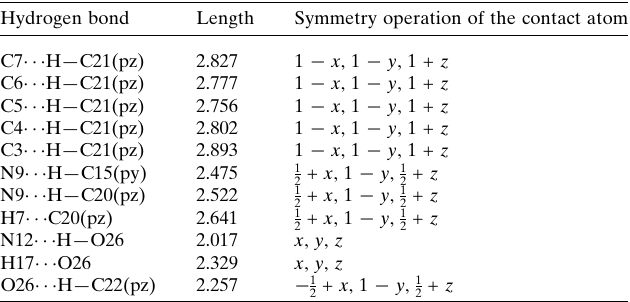
Table 1 Hydrogen bonding (A˚ ) of the title